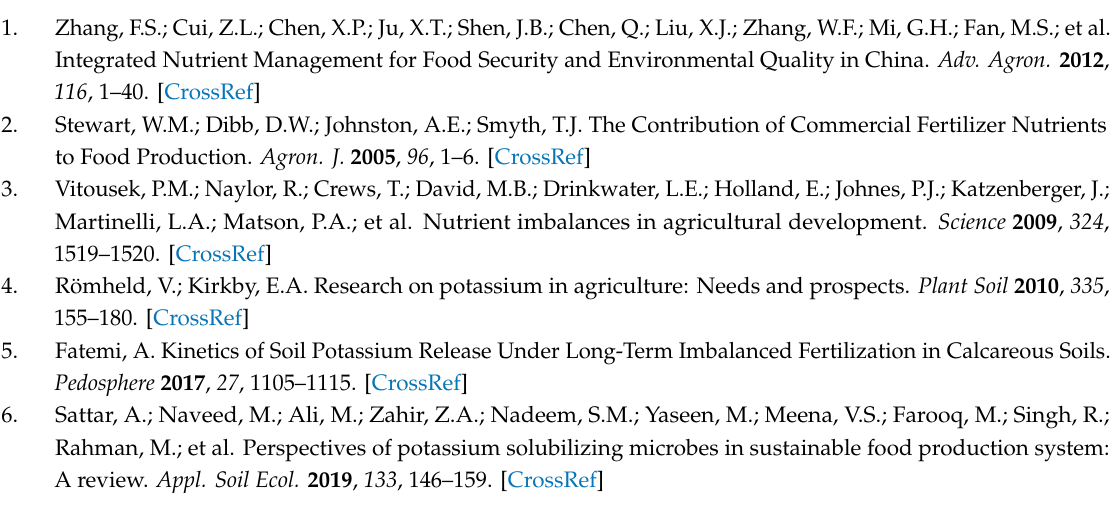
Figure S1: Comparison of wheat grain yield after 27 years of fertilization treatments (CK: no fertilizer; NP: nitrogen and phosphorous fertilizer; NPK: nitrogen: phosphorus: and potassium fertilizer) in a wheat–fallow system. Figure S2: Linear relationship between soil available K and microbial biomass C (a) and microbial biomass N (b), Figure S3: Relation analysis between MBC and the microbial community